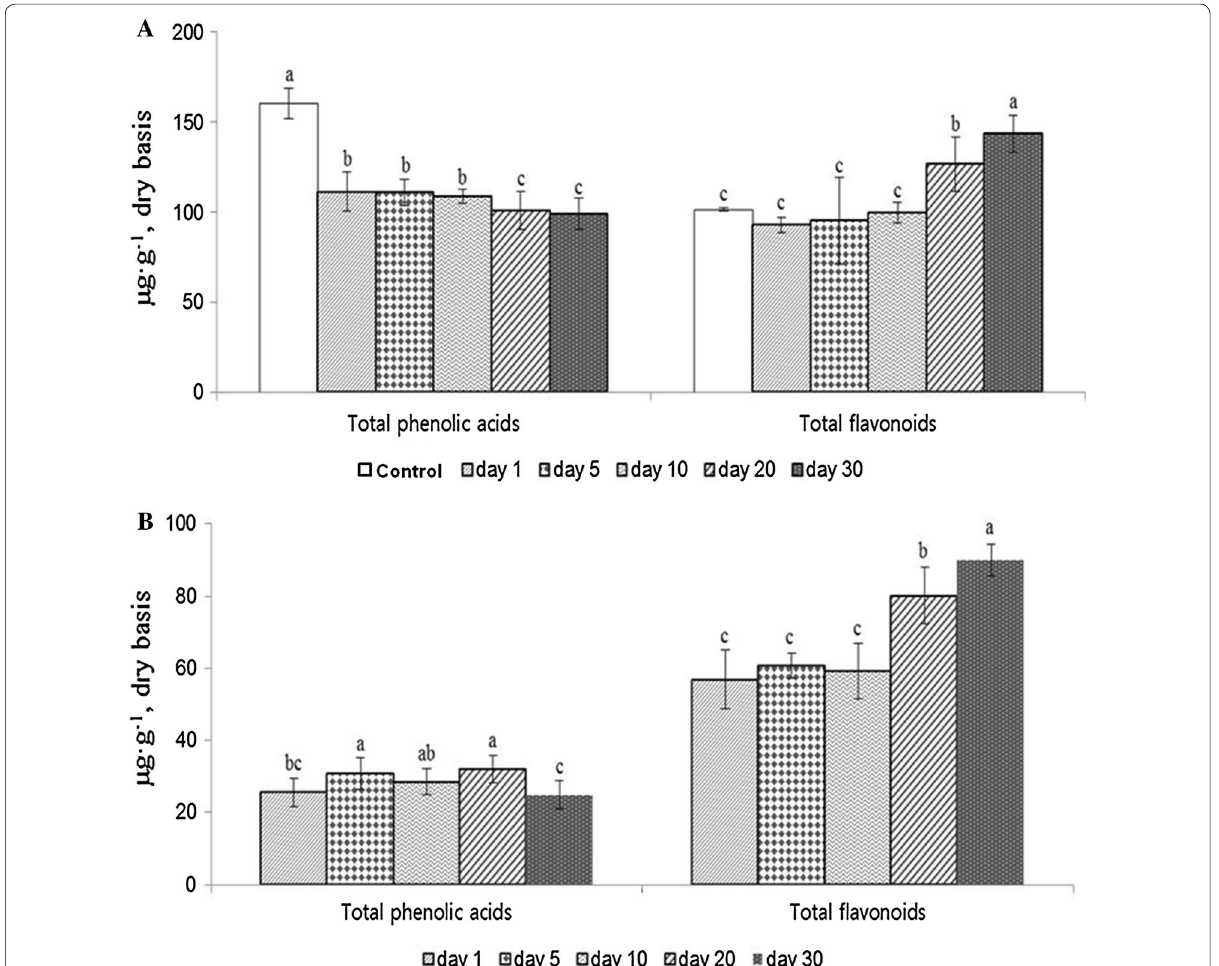
Fig. 2 Changes in the total phenolic acids and total flavonoids in the pickled soybeans ( A ) and the pickling solution ( B ) according to pickling period over 30 days ( P < 0.05, n 3). Control: untreated soybeans; day 1–30: the pickling =